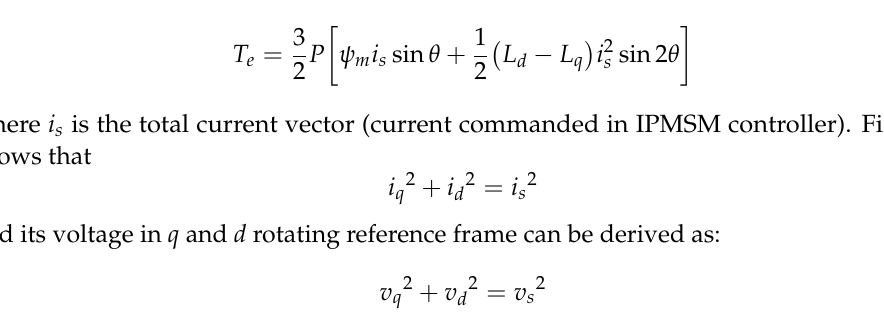
Figure 3. Vector representation of i q and i d in rotating current reference frame ( d;q ). The substitution of 𝑖 (cid:3044) = 𝑖 (cid:3046) sin 𝜃 and 𝑖 (cid:3031) = 𝑖 (cid:3046) 𝑐𝑜𝑠 𝜃 in Equation (3) generated the torque for the IPMSM with respect to its rotating reference frame d;q as follows.